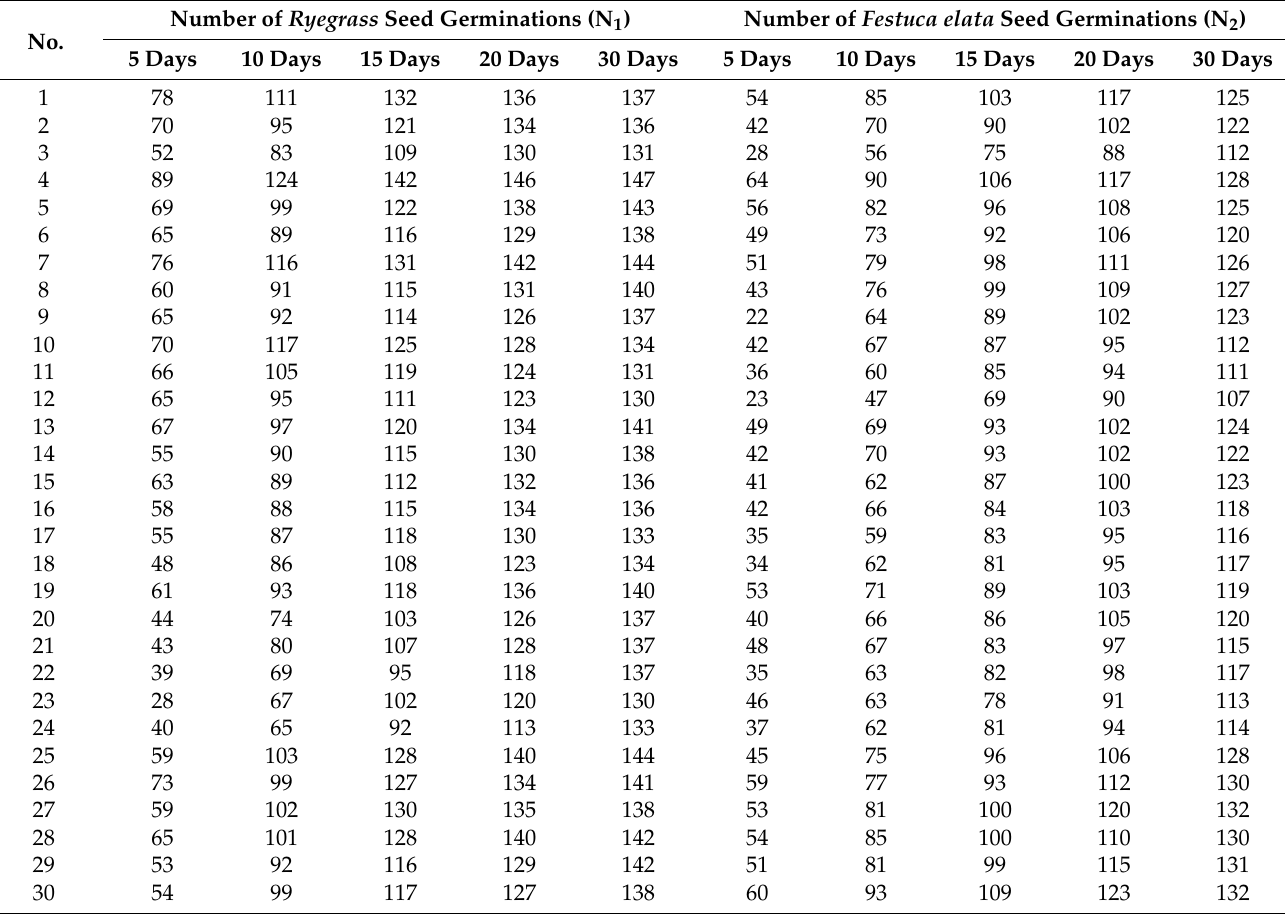
Table 3. Relationship between seed germination and planting